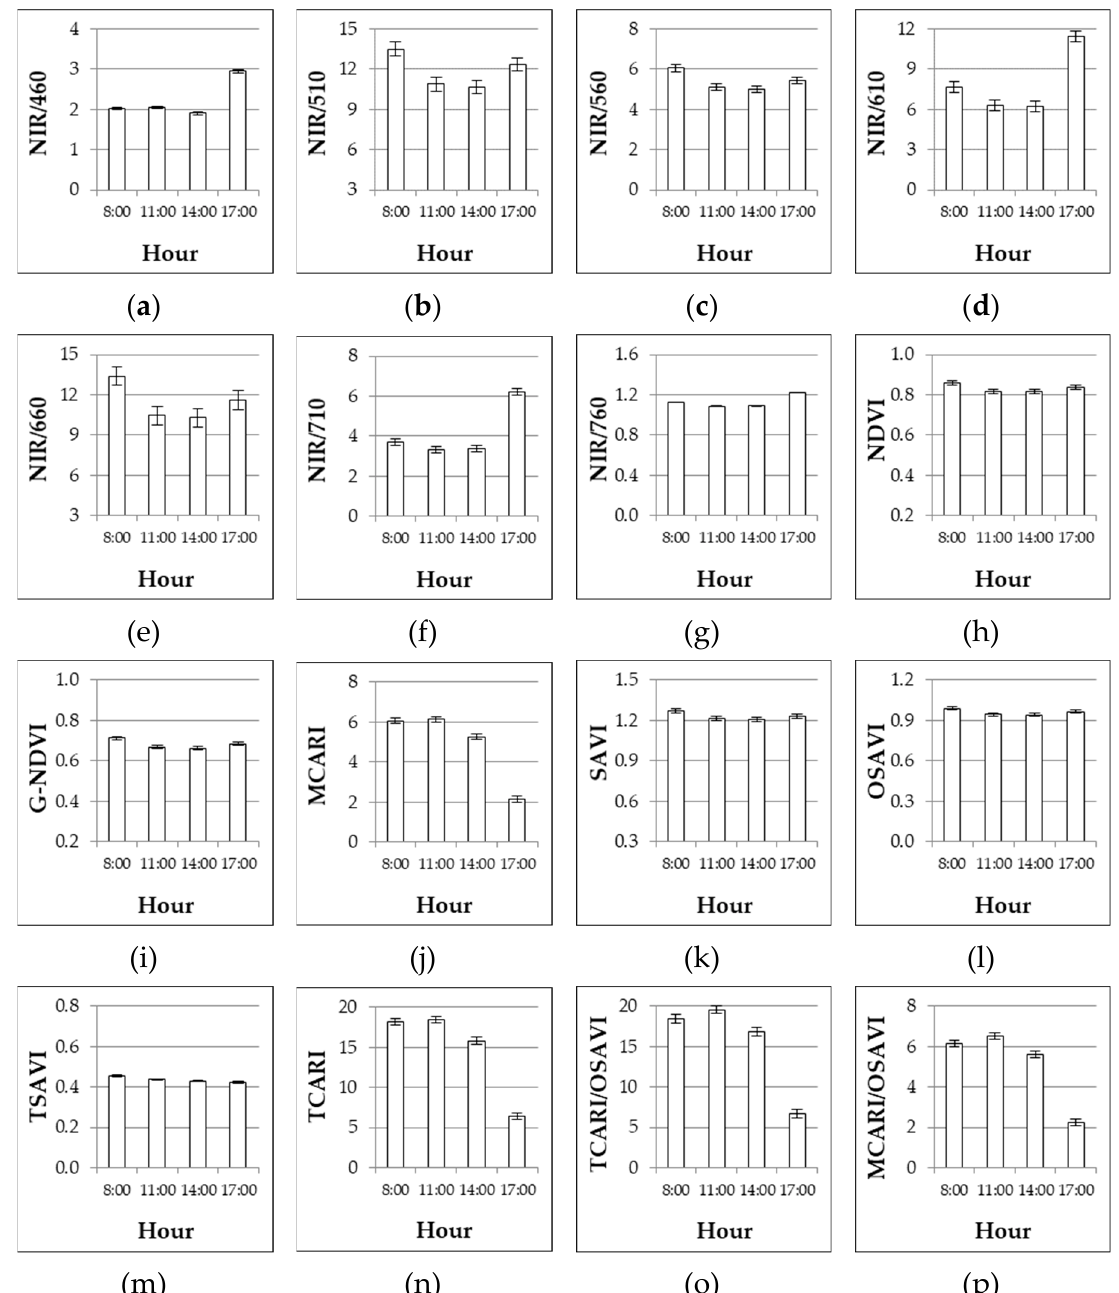
Figure 3. Experiment 3#. Influence of the hours of the day on di ff erent VIs as assessed at 68 DAT. Mean values ±